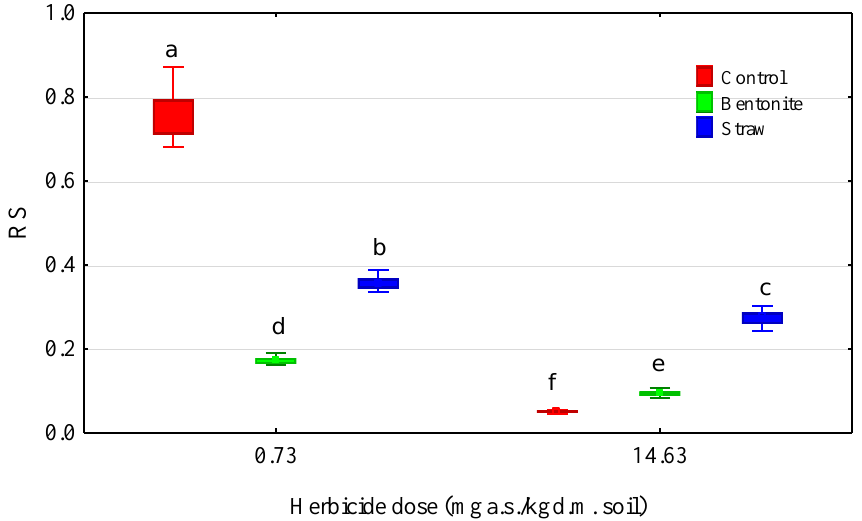
Figure 8. Resistance index (RS) of maize to soil contaminated with Successor T 550 SE. The same letters denote homogeneous groups.